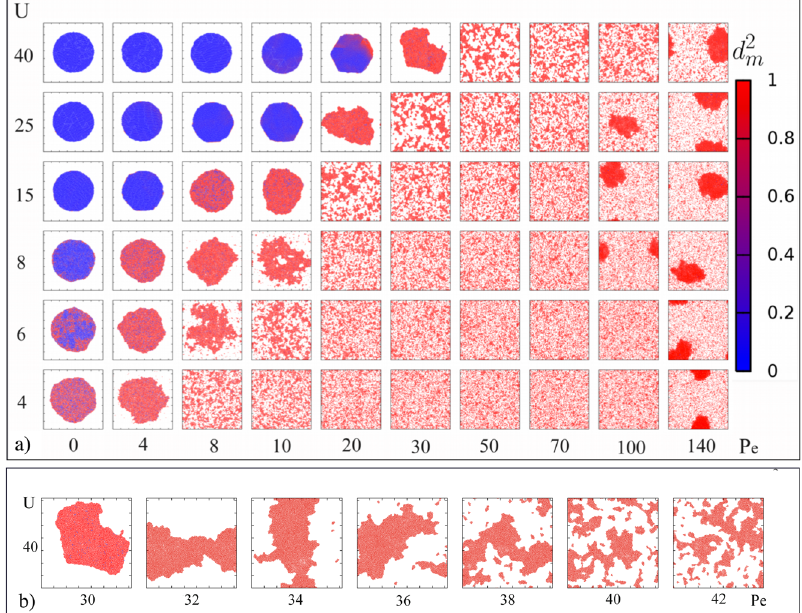
Fig. 1 Visual phase diagram. a Phase diagram illustrated by snapshots at the end of simulation. Here we plot the mobility pro fi le as a function of attractive interaction U and activity Pe. We start the simulation with initial circular patch. The color code de fi nes the magnitude of mobility. Blue means immobile and red means highly mobile colony. ( (cid:1) σ = σ ¼ 0 : 3; overall packing fraction is 0.274). See Supplementary Movies 1 and 2 for the formation and dynamics of the cohesive colony at liquid vacuum coexistence for U = 40, Pe = 30. b Close-up of the transition region from L – V coexistence to the “ many clusters ” regime at U = 40. Above Pe ≥ 30, the system is in the regime of a liquid colony with detached clusters, with a smooth crossover to many small clusters for Pe ≥